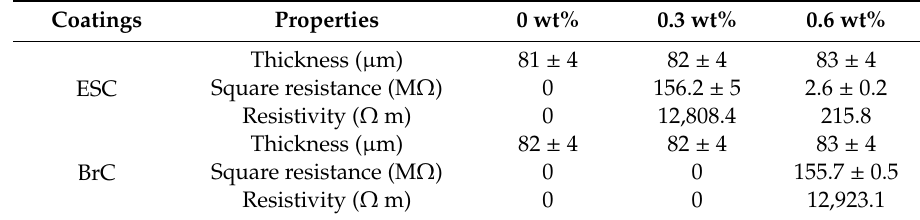
Table 1. Electrical conductivity of WPU coatings with di ff erent MWCNT contents.